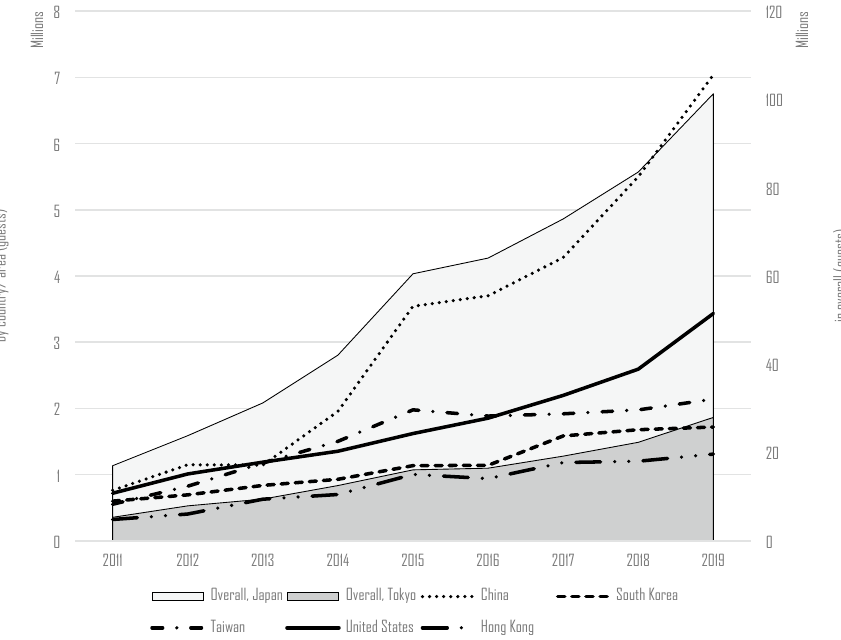
Fig. 1 Accumulated number of guests at accommodations. Source: Japan National Tourism